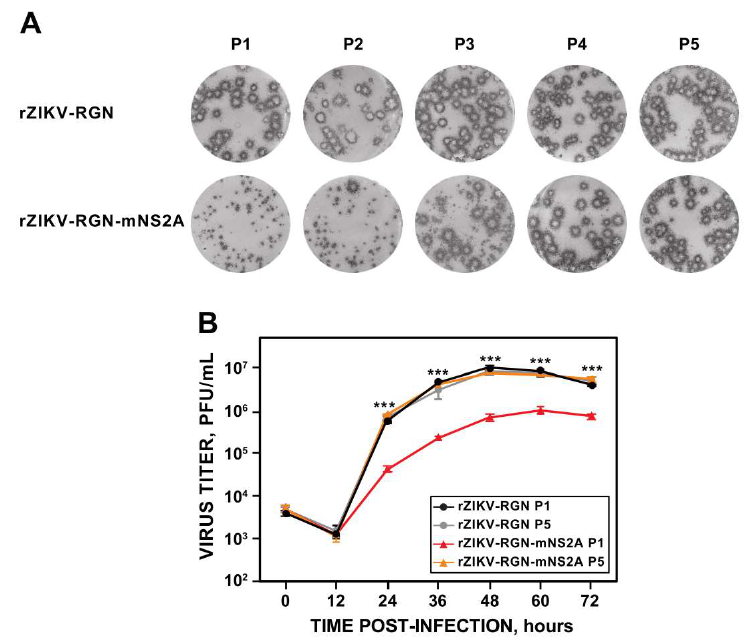
Figure 8. Stability of rZIKV-RGN-mNS2A in cultured cells. Vero cells growth in 6-well plates at 90% of confluence were infected with 0.1 PFU/cell of rZIKV-RGN or rZIKV-RGN-mNS2A. At 72 hpi, cell culture supernatants were collected and used to infect fresh Vero cells. This process was repeated four more times and virus stocks of passages 1 to 5 (P1 to P5) were generated. ( A ) Plaque size. Vero cells were infected with the different passages (P1 to P5) of rZIKV-RGN or rZIKV-RGN-mNS2A, and at four days post-infection the viral plaques were visualized by immunostaining using the pan-flavivirus E protein mAb 4G2. ( B ) Growth kinetics. Vero cells at 90% confluence (24-well plate format; triplicates) were infected (MOI of 1 PFU/cell) with P1 and P5 of rZIKV-RGN or rZIKV-RGN-mNS2A and at the indicated hpi, virus titers were determined by plaque assay. Error bars represent standard deviations of the mean from three experiments. Asterisks indicate that the differences between rZIKV-RGN-mNS2A P1 and the experimental samples, rZIKV-RGN P1, rZIKV-RGN P5 and rZIKV-RGN-mNS2A P5, are statistically significant when data are compared using the unpaired t test (***, P < 0.001).